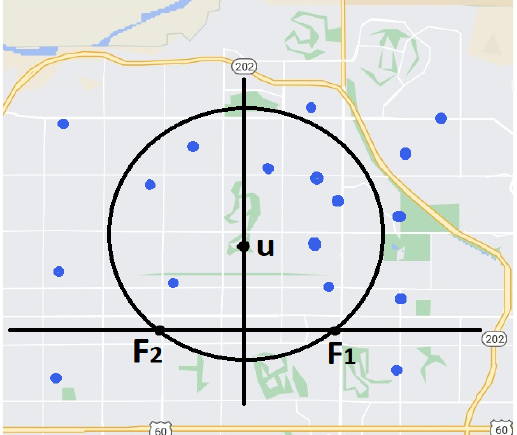
Figure 1. The constrained optimization model of monitoring a crowd crush risk by using the position of cell phones. The constraint is to pass through F 1 and F 2 . The blue dot is the position of the cell phone. F 1 and F 2 are constrained points. u is the optimal solution of minimax problem with radius r